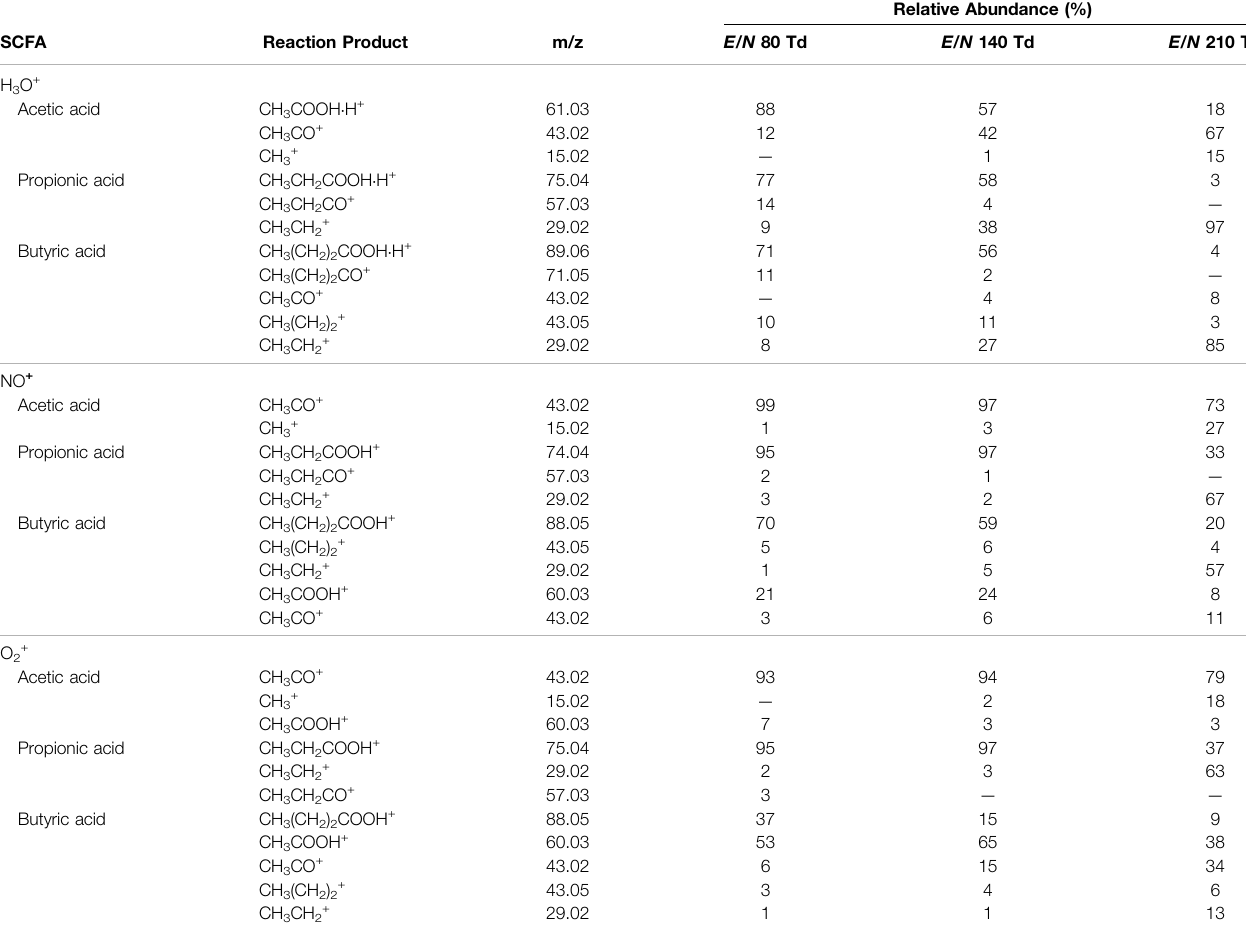
TABLE 1 | Drift tube reactions with H 3 O + and ion branching ratios of SCFAs at selected reduced electric fi elds under humid conditions.